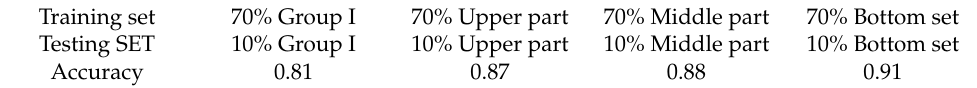
Table 7. Accuracy results of Group I.